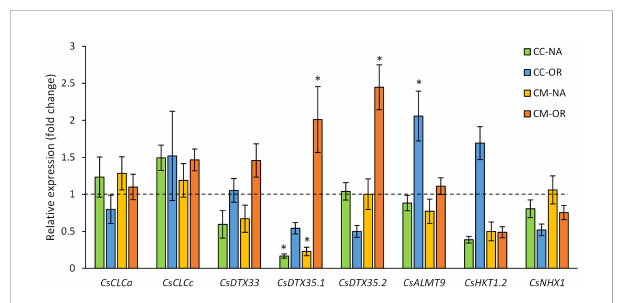
FIGURE 8 Gene expression. Relative expression of genes involved in Cl − and Na + uptake in the vacuoles in CC-NA (green bars), CC-OR (blue bars), CM-NA (yellow bars), and CM-OR (orange bars) in control and 90 mM NaCl stressed plants. Data are mean of three replicates ± standard error. Asterisks denote statistically signi fi cant differences between control and salt-stressed plants of each scion/rootstock combination at p ≤